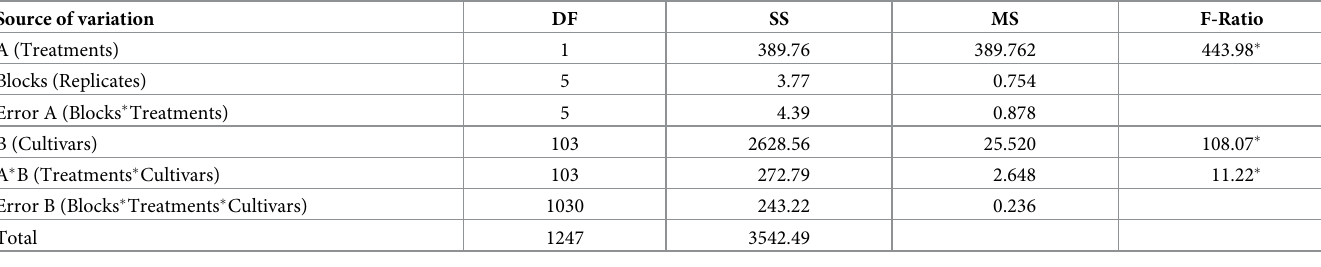
Table 2. Analysis of variance of cultivars and disease treatments for brix contents.